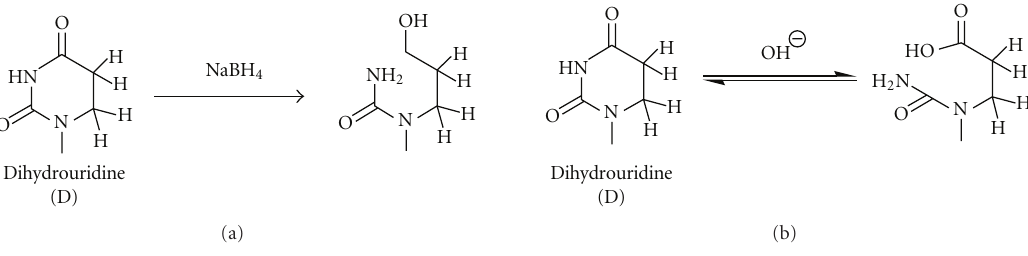
Figure 8: Cleavage of the dihydrouridine ring (a) upon reduction by sodium borohydride (NaBH 4 ) and (b) at mild alkaline conditions. In both cases, cleavage of the dihydrouridine ring is followed by cleavage of the RNA chain.